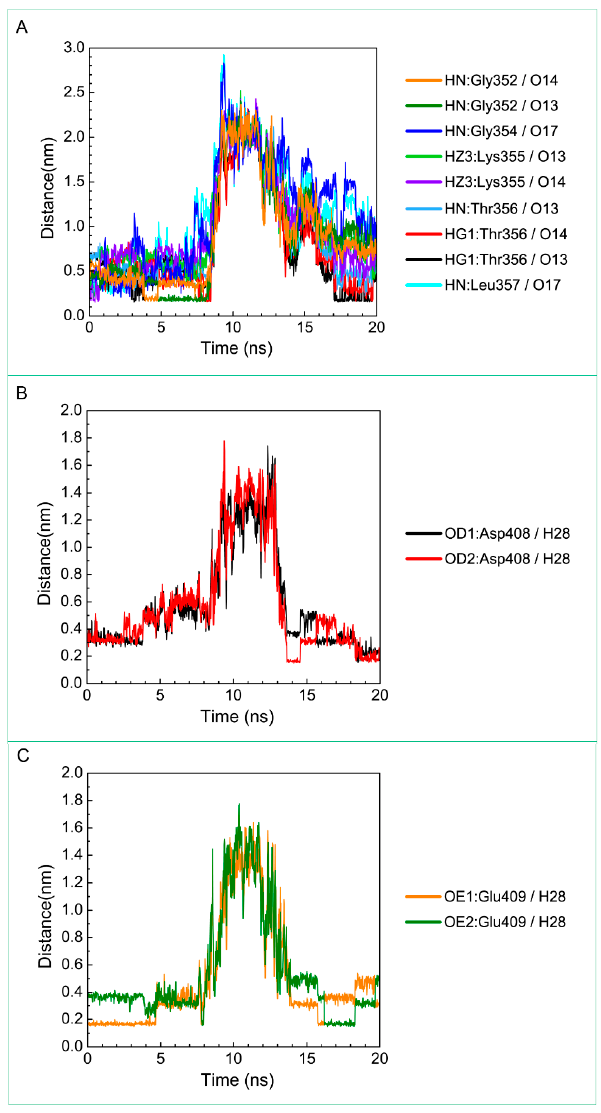
Figure 11. Distance variation of H-bonds for paraplegin complexes with 5-hydroxy- L -tryptophan during MD simulation. Display the distances between compound and amino acids ( A ) Gly352, Gly354, Lys355, Thr356, Leu357, ( B ) Asp408, and ( C ) Glu409.